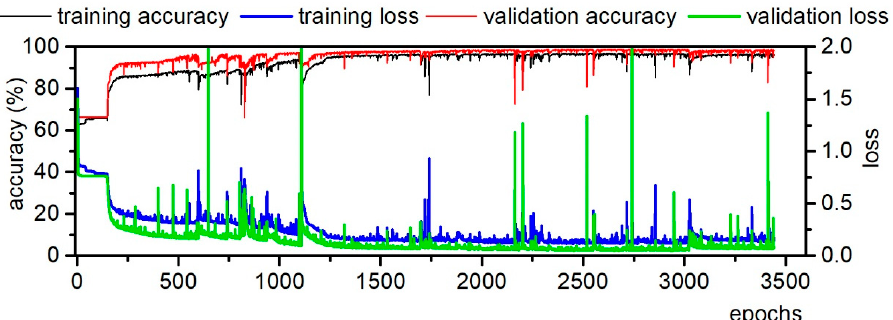
Figure 3. Accuracy and loss curve for training deep neural networks (DNN) in neural network-based sample augment (NNSA).